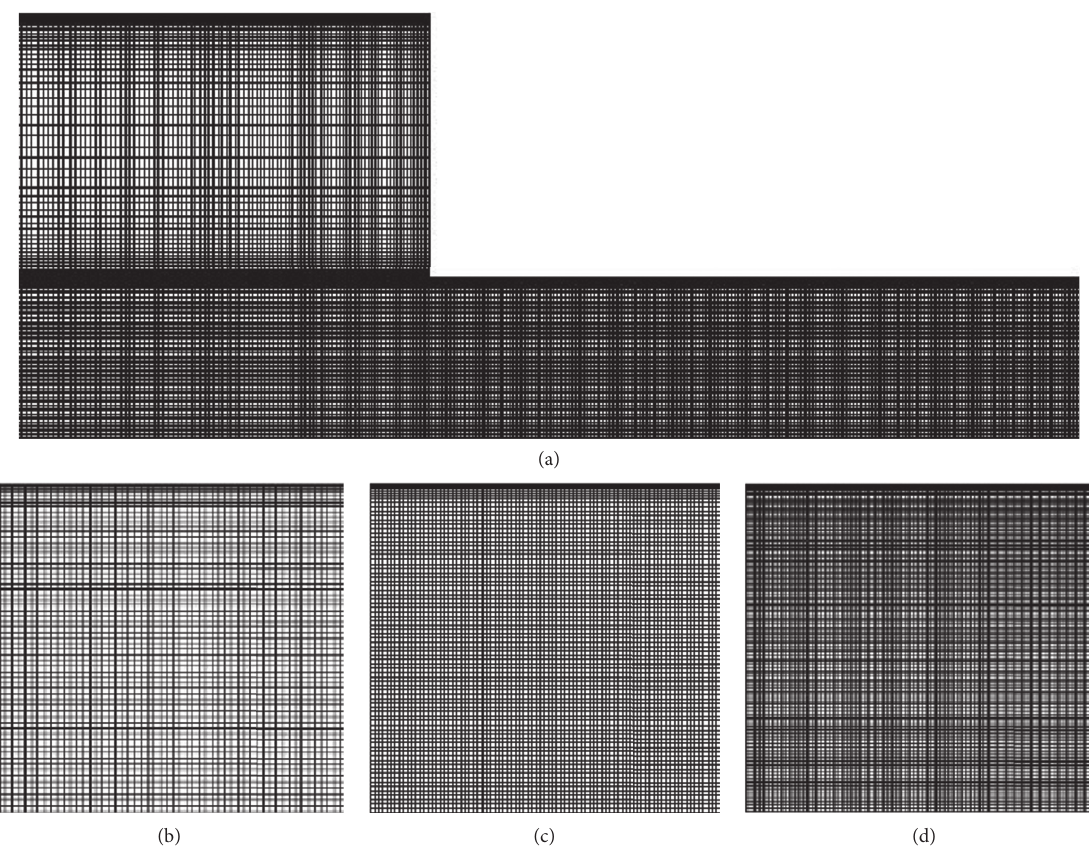
Figure 4: Partial computational grids used for numerical simulation. (a) Partial computational grids. (b) 89000. (c) 192000. (d)